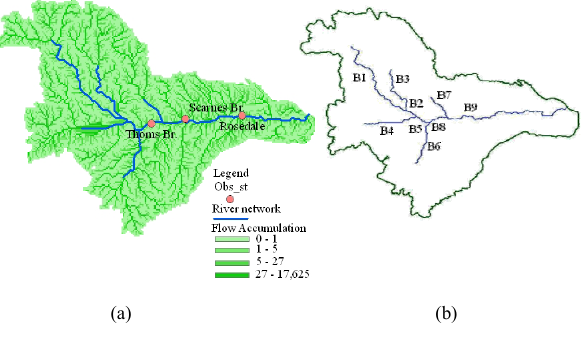
Fig. 17. Flow accumulation map and river network for Latrobe River Basin modeling.